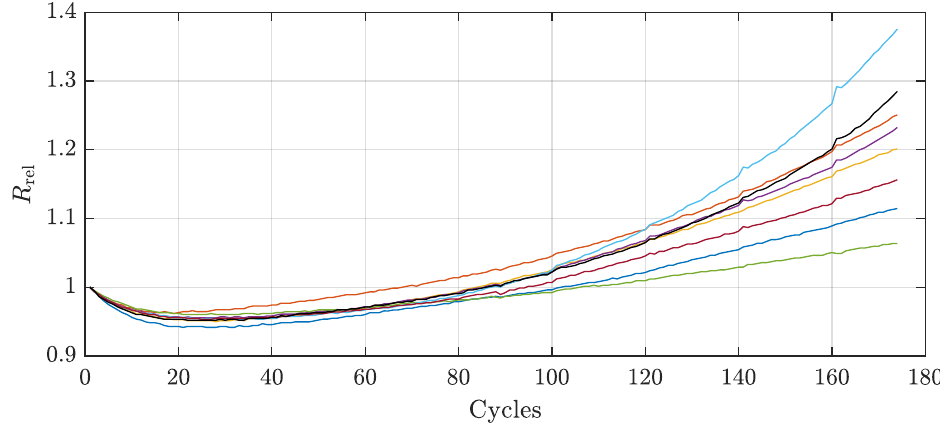
Figure 4. Relative internal resistance of all 8